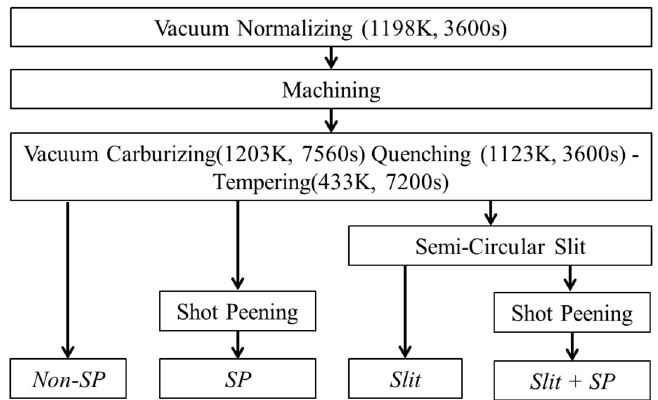
Figure 2. Flow chart of the specimen manufacturing process.